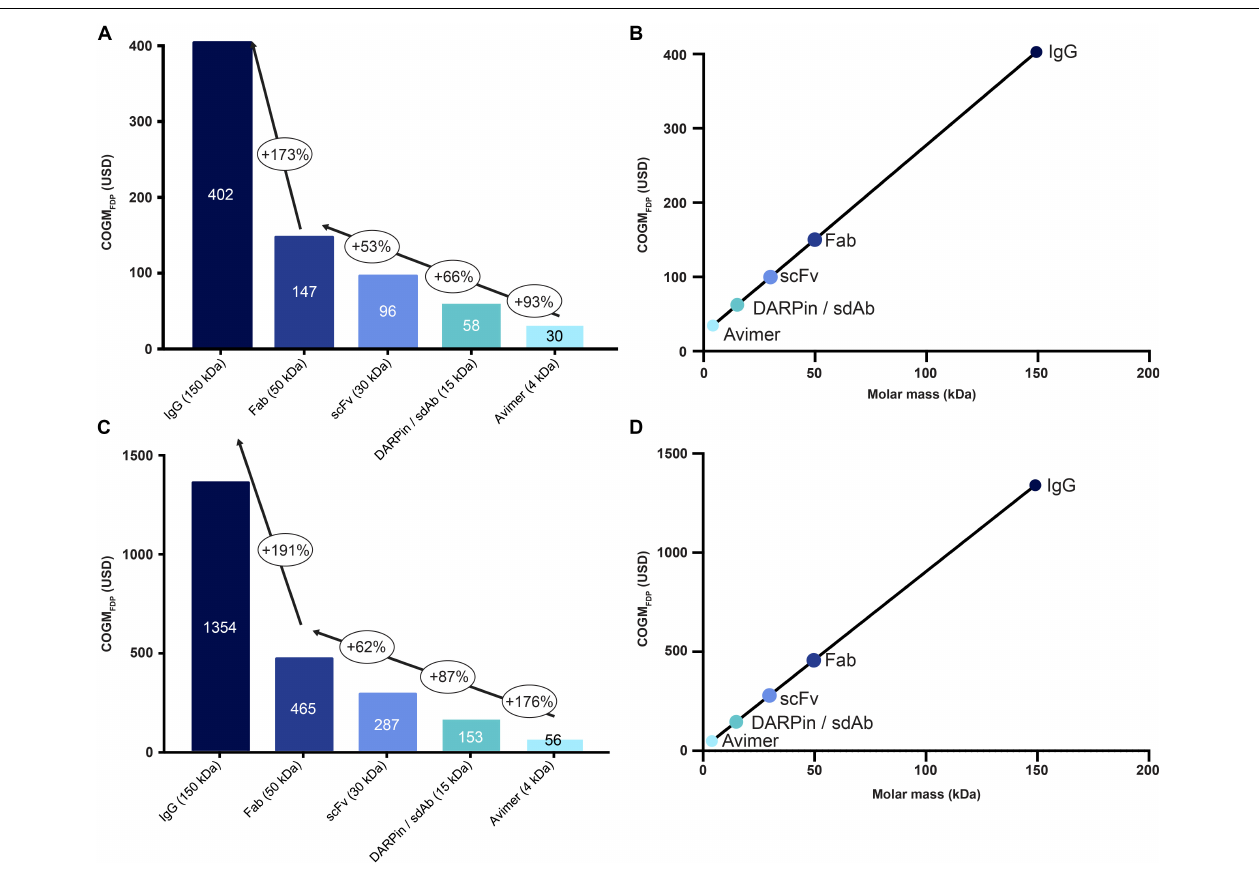
FIGURE 6 | The influence of molar mass of the antitoxin on the cost of recombinant antivenoms for different antibody formats and alternative antitoxin scaffolds. Here, we calculated the cost of a polyvalent recombinant antivenom for sub-Saharan Africa, using an “expected” (A) and a “worst case” scenario (C) of 1:1 and 1:3 toxin-to-antibody ratio, respectively; the former (A) assumes 25% cross-reactivity for the antitoxins, while the latter is calculated without any cross-reactivity. The included formats include IgG, Fab, scFv, DARPin/sdAb, and Avimer. The bubbles indicate the percentage of cost increase from one format to the next and the text in the columns indicate the cost of the final drug product. Correlation between molar masses of the different antitoxin formats and the Cost of Goods Manufactured for the Final Drug Product (COGM FDP ) of the recombinant antivenom is given for both the “expected” (B) and the “worst case” scenario (D) , respectively.